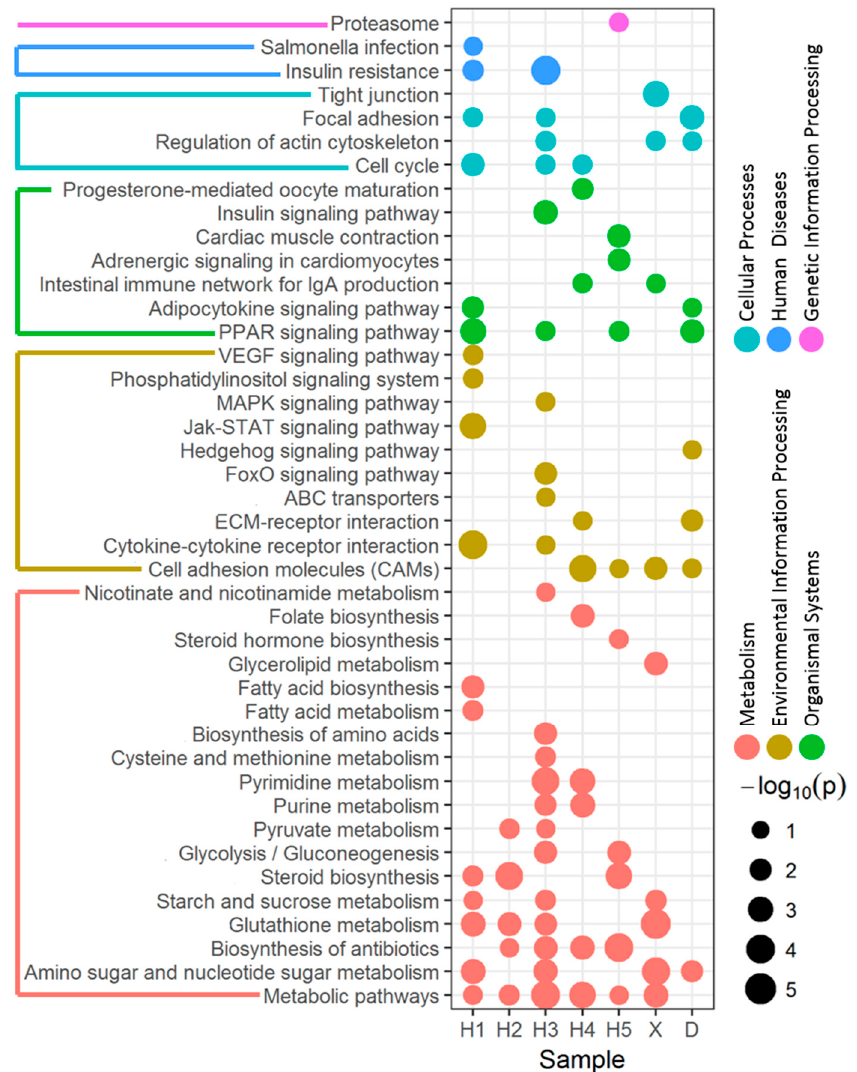
Figure 3. Pathway enrichment analysis of DEGs in liver of zebrafish exposed to surface water. The area of circle represents − log 10 (p), that bigger circles have lower p values. The color of circles indicates functional categories of pathways.